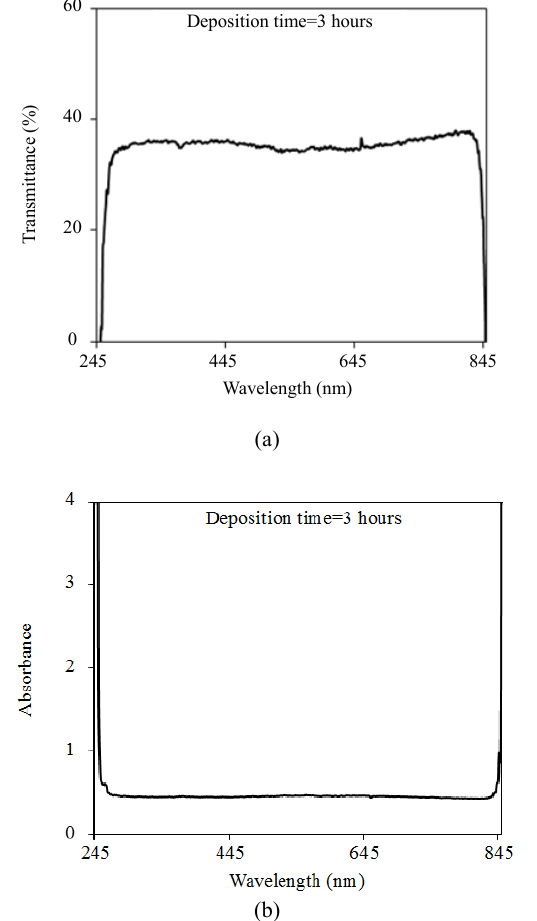
Fig. 2 Transmission (a) and absorption (b) spectra of the nanostructured SiO 2 film prepared in this work after deposition time of 3